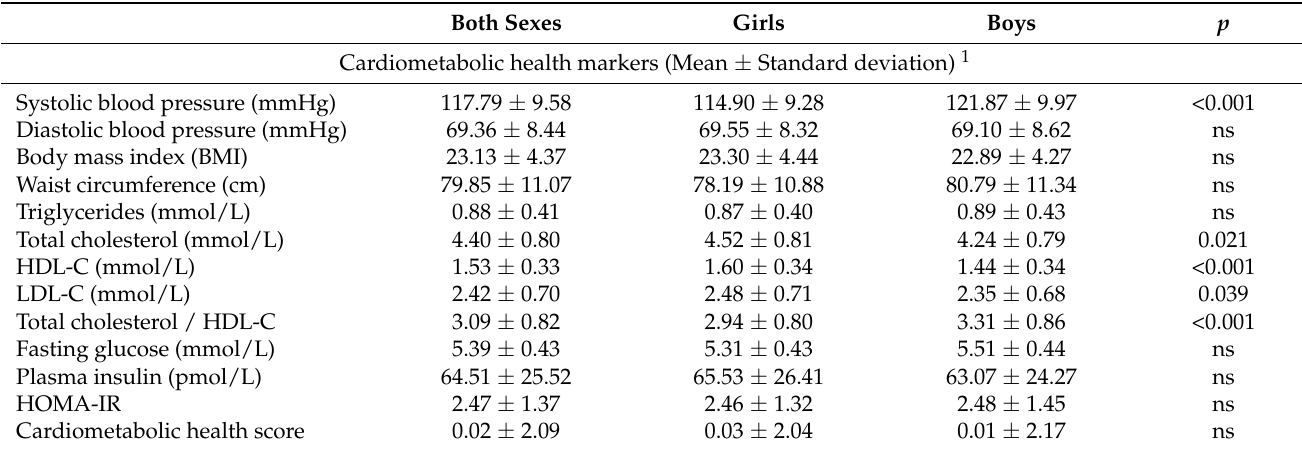
Table 2. Descriptive characteristics of cardiometabolic health markers and movement behaviors according to the sex of the adolescents participating in the study. Both Sexes Girls